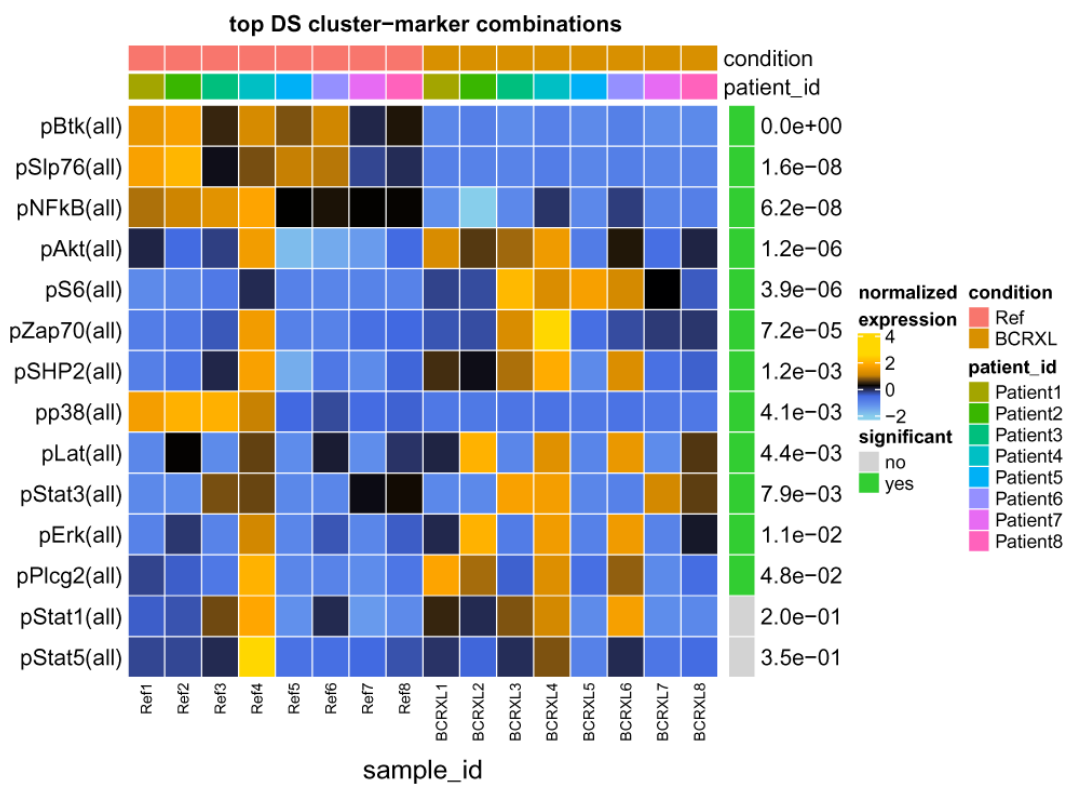
Figure 26. DS test results and normalized expression of signaling markers calculated over all cells in PBMC populations in BCR/FcR-XL stimulated and unstimulated conditions. The heat represents median (arcsinh- transformed) marker expression that was subsequently normalized per marker (rows) to mean of zero and standard deviation of one. The color of the heat varies from blue representing relative under-expression to orange representing relative over-expression. Bars at the top of the heatmap indicate patient IDs and the condition the samples (columns) belong to: red for the unstimulated (Ref) and brown for the stimulated with BCR/FcR-XL (BCRXL) condition. Bar and numbers at the right indicate significant differential markers (green) and adjusted p-values. Markers are sorted according to adjusted p-value, so that the marker at the top shows the most significant change between the two